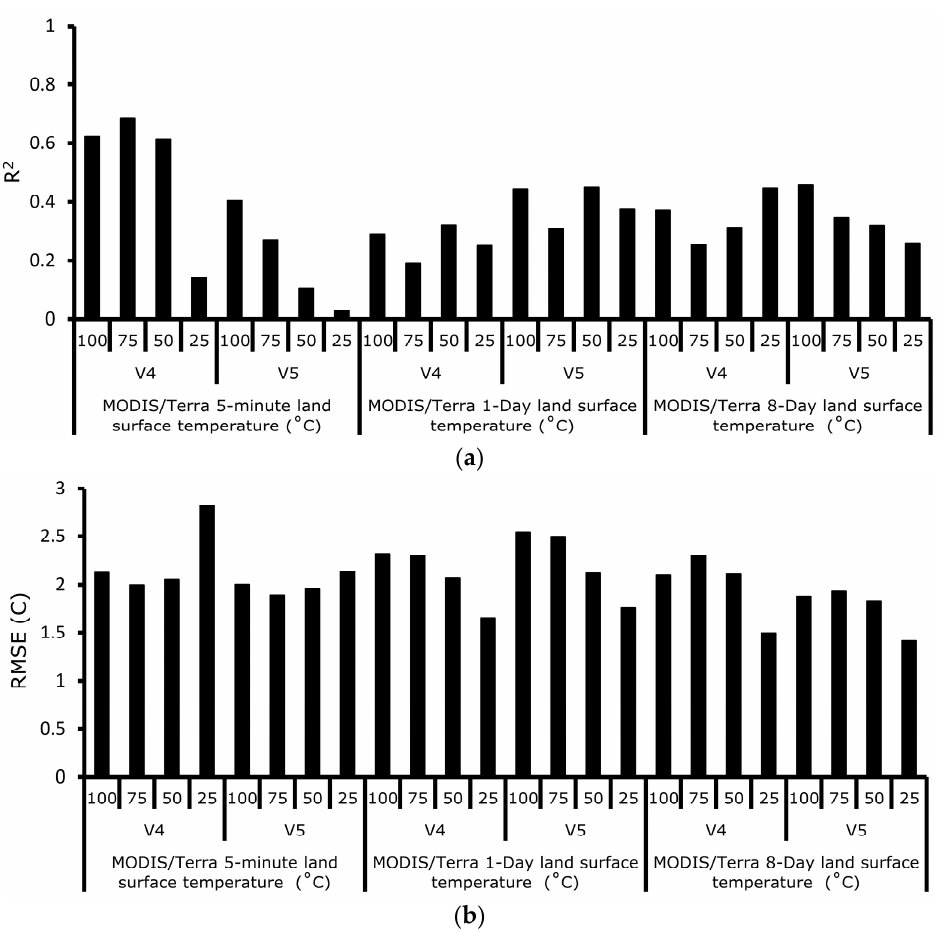
Figure 4. ( a ) Correlation (R 2 ) and ( b ) RMSE, between impervious percentage and MODIS/Terra land surface temperature at 960 m resolution, using different threshold pixel selections scenarios (25%, 50%, 75% and 100%).